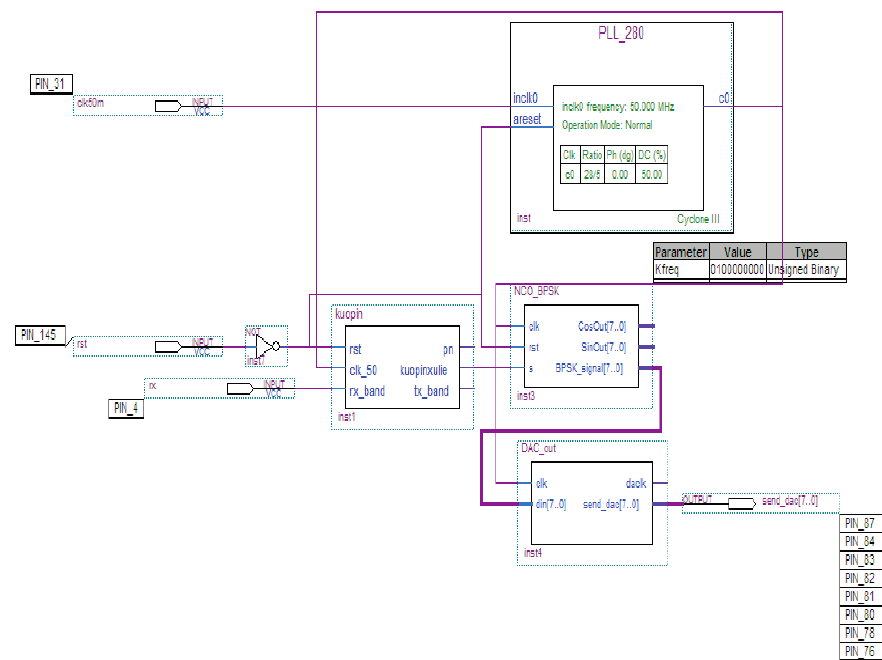
Figure 33. The top-level design of the Direct Sequence Spread Spectrum (DSSS)